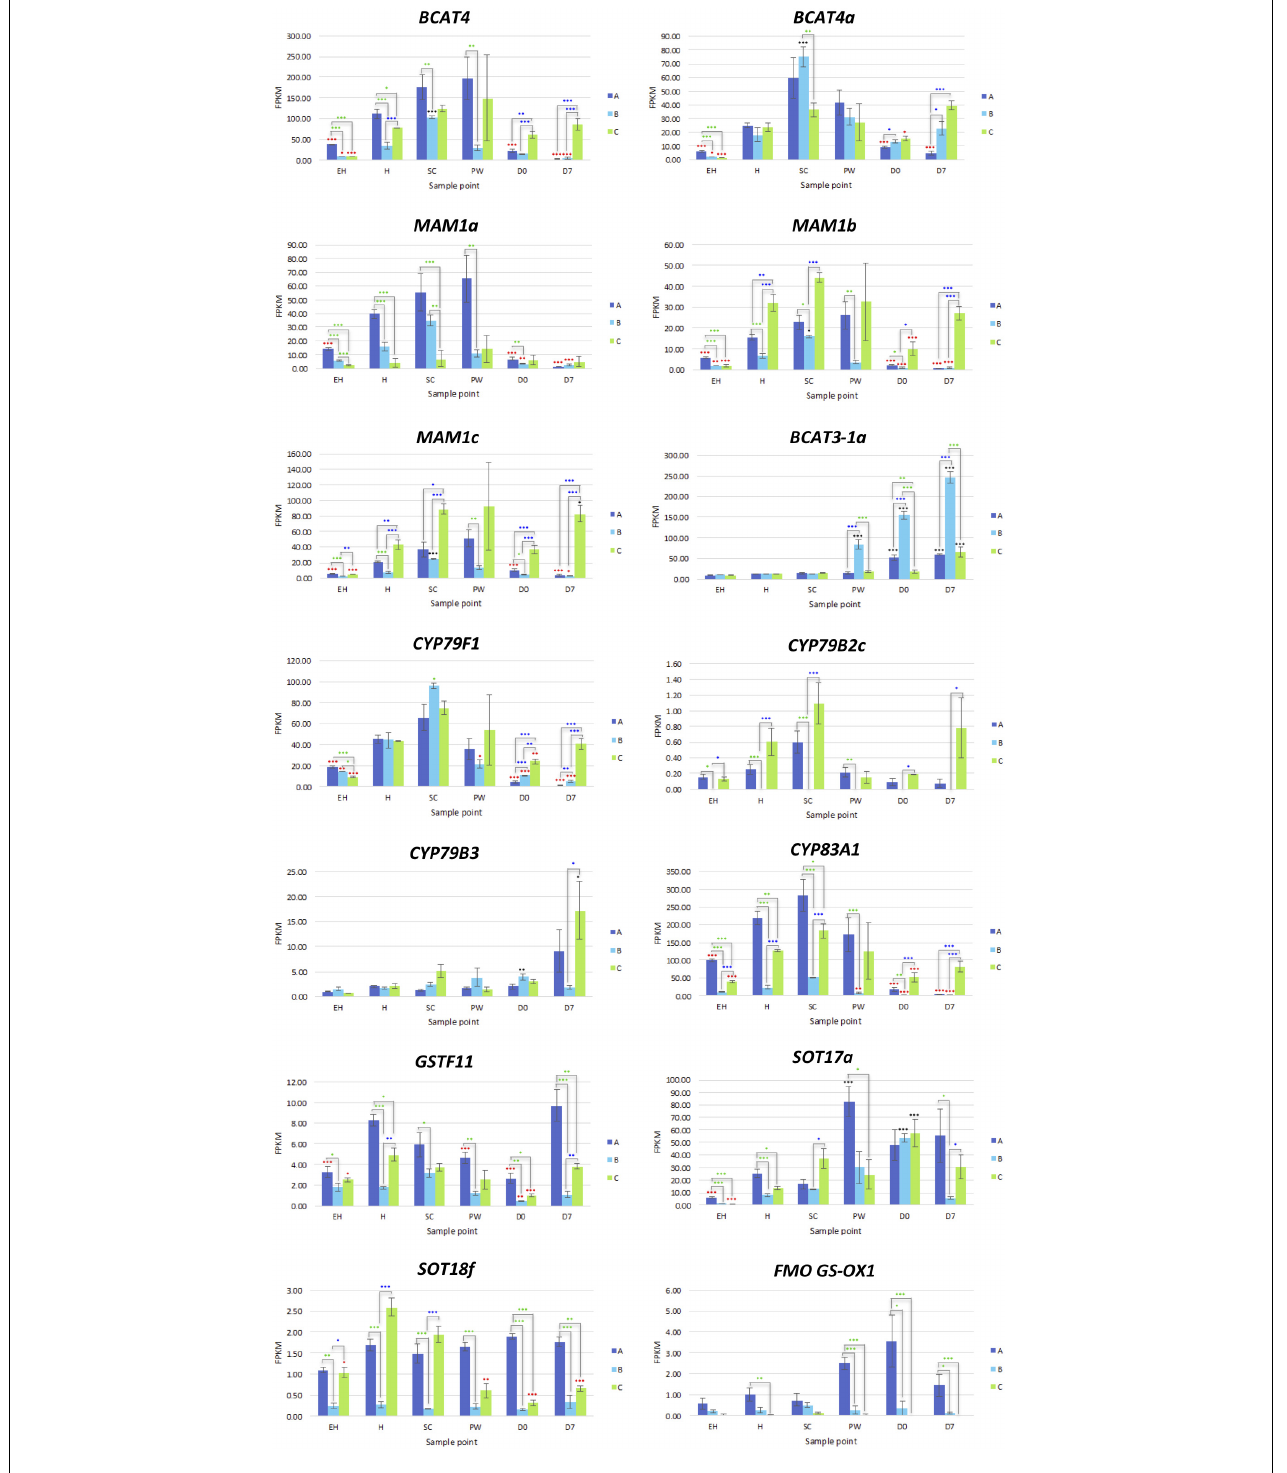
FIGURE 7 | RNAseq expression data (FPKM) for genes involved with glucosinolate biosynthesis in three elite inbred lines of Eruca sativa ( A , dark blue; B , light blue; C , green). Standard errors of the mean expression values are represented by error bars. Asterisks denote levels of significance of up and down regulation within sample points (between each inbred line) and relative to the point of harvest for each respective sample point: * p ≤ 0.05; ** p ≤ 0.01; *** p ≤ 0.001; green, significant up regulation between lines A , B , and C ; blue, significant down regulation between lines A , B , and C ; black, significant up regulation relative to H ; red, significant down regulation relative to H . EH , early harvest; H , harvest; SC , second harvest; PW , pre-wash; D0 , post-wash; and D7 , 7-day shelf life.